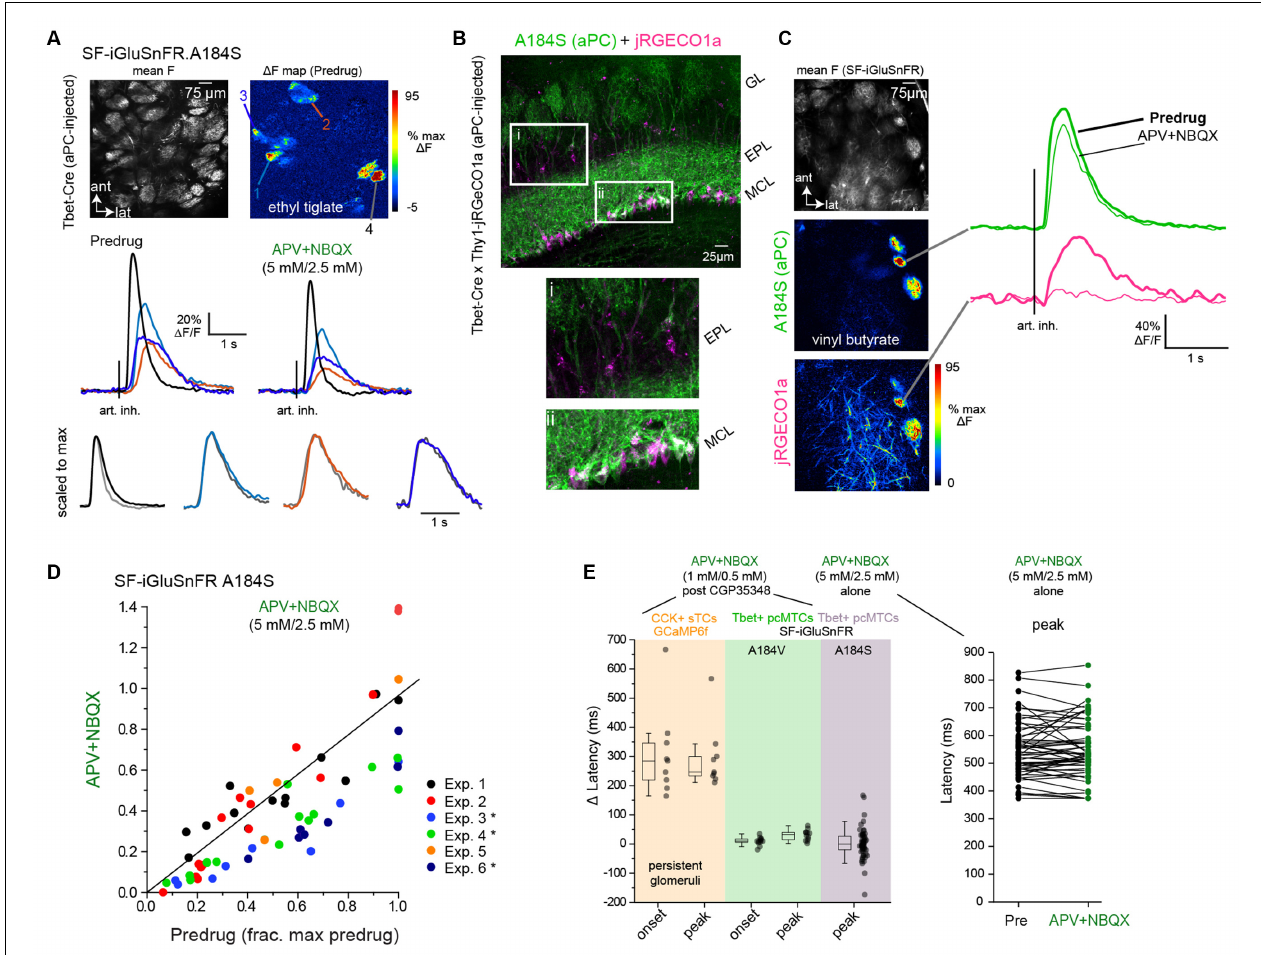
FIGURE 5 | Dual-color imaging confirms small impact of multisynaptic excitation on glutamatergic input to MT cells. (A) Top: Mean fluorescence and ∆ F response maps showing odorant-evoked (ethyl tiglate, 0.7 ppm) glutamate signals in several glomeruli after SF-iGluSnFR.A184S (A148S) expression in pcMT cells. Bottom: Inhalation-triggered average (ITA) responses from four of the glomeruli, imaged before and after application of APV+NBQX (5 mM/2.5 mM). Response amplitudes in each glomerulus are modestly reduced, but relative latencies and durations are unchanged. Lower traces show ITAs for each of four glomeruli, before and after APV+NBQX application, scaled to the same maximum (gray trace is post-drug). (B) Dual imaging of glutamate and Ca 2+ from overlapping subsets of MT cells. Left: post hoc histology showing expression of SF-iGluSnFR.A184S in pcMTs (green) and Thy1-driven jRGeCO1a expression in MT cells (magenta), in a Tbet-Cre × Thy1-jRGECO1a mouse cross. Insets highlight expression in the external plexiform layer (EPL) and mitral cell layer (MCL). Note that SF-iGluSnFR is expressed preferentially in mitral cells, while jRGECO1a is expressed in both mitral cells and tufted cells in the EPL. (C) Left: Mean SF-iGluSnFR.A184S fluorescence and ∆ F response maps for SF-iGluSnFR.A184S and jRGECO1a, imaged simultaneously in response to odorant stimulation (vinyl butyrate, 3 ppm). Right: ITA traces for the SF-iGluSnFR.A184S (green) and jRGECO1a (magenta) signals imaged from the same glomerulus, comparing Predrug (bold line) and APV+NBQX conditions. (D) Top: ITA response amplitudes before and after APV+NBQX (5 mM/2.5 mM) application in pcMT cells from six experiments. In each experiment, odorant was presented at two concentrations varying by a factor of 2.5–10; each point indicates a particular glomerulus-concentration response, before and after drug application. Responses are normalized to the maximal pre-drug response in each experiment. Asterisks indicate experiments with significant change in ITA response amplitude. Summary statistics per experiment (mean ± SD APV+NBQX/Predrug ratios, paired t-tests with Bonferroni correction, n = glom − odor concentration pairs): Exp. 1, 1, 07 ± 0.35, p = 1.0, n = 13; Exp. 2, 0.83 ± 0.41, p = 1.0, n = 16; Exp. 3, 0.45 ± 0.15, p = 0.012, n = 8; Exp. 4, 0.58 ± 0.14, p = 3.7 × 10 − 4 , n = 14; Exp 5, 0.97 ± 0.29, p = 1.0, n = 4; Exp 6, 0.53 ± 0.13, p = 8.2 × 10 − 3 , n = 7. (E) Little change in onset latencies and peak times of inhalation-linked responses after APV+NBQX application. Left plot: change in latency measurements from CCK+ GCaMP6f datasets (persistent glomeruli, same data as Figure 3G ), pcMT SF-iGluSnFR.A184V with 1 mM/0.5 mM APV+NBQX (data in Figure 4D ), and pcMT SF-iGluSnFR.A148S with 5 mM/2.5 mM APV+NBQX. Onset latencies were not measured for the final dataset due to the relatively low signal-to-noise ratio of these responses. Right plot: Peak latencies relative to inhalation for each ROI in 5 mM/2.5 mM APV+NBQX dataset. Note no change in latencies for iGluSnFR signals. Boxes indicate 25th and 75th percentiles, line indicates median, and whiskers denote outliers with a coefficient of